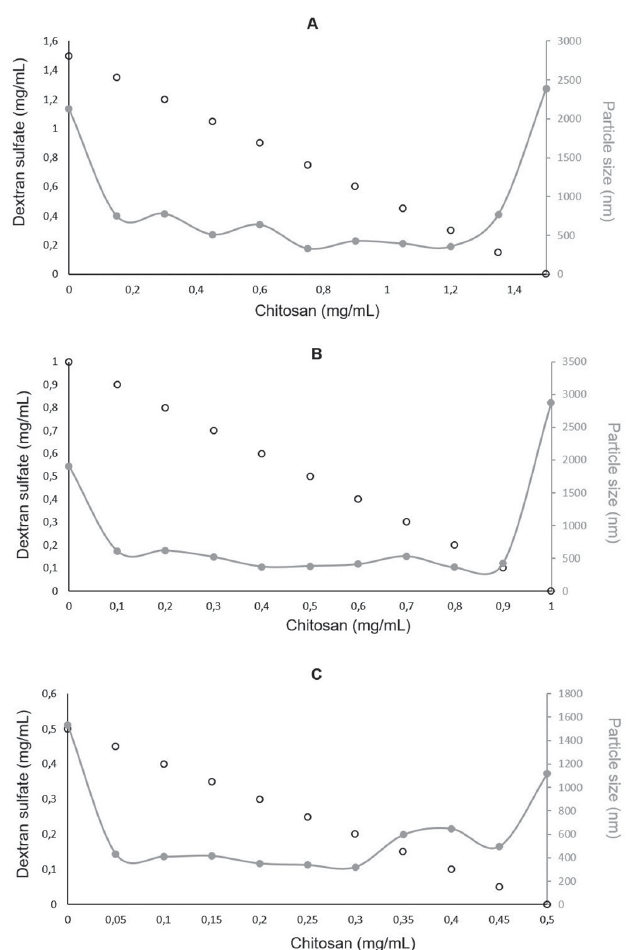
FIGURE 1 - Study of the influence of total excipient concentration (A = 1.5 mg/mL, B = 1.0 mg/mL and C = 0.5 mg/mL) and the ratio of dextran sulfate/chitosan (open circle) on particle size (gray closed